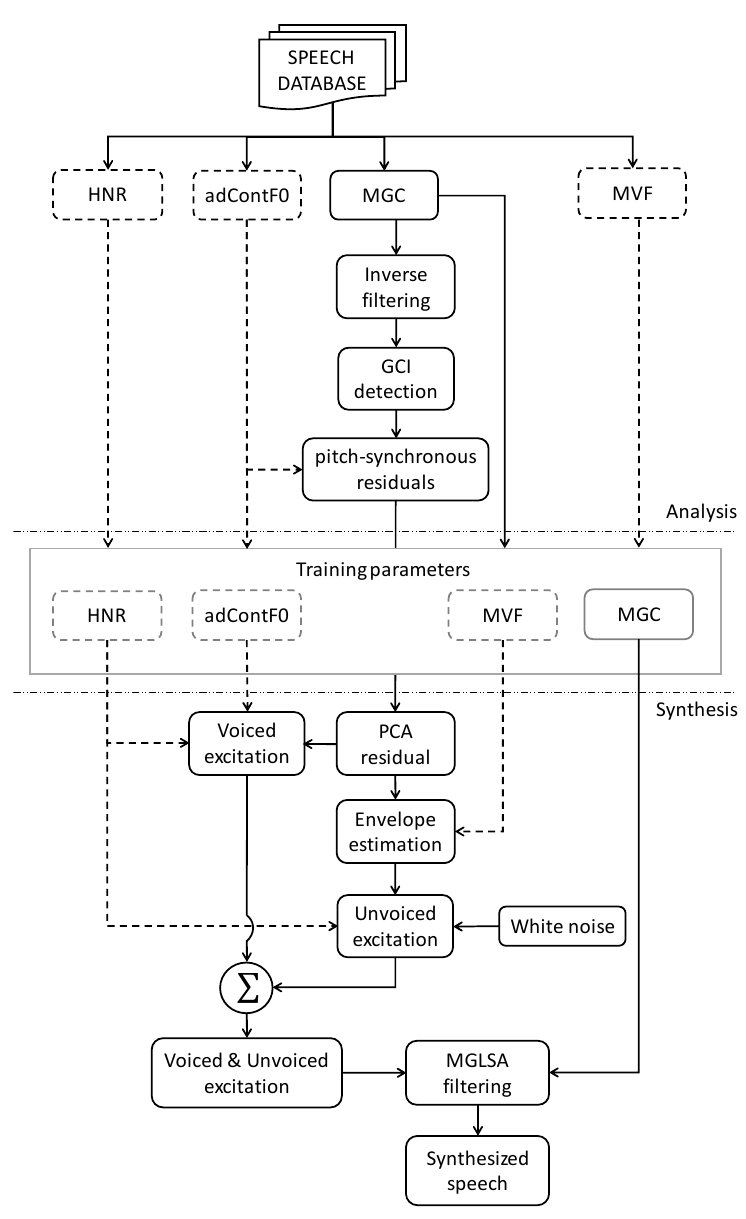
Figure 3. Illustration of the parametrization of speech with the continuous vocoder. Additions and refines are marked with dashed lines.